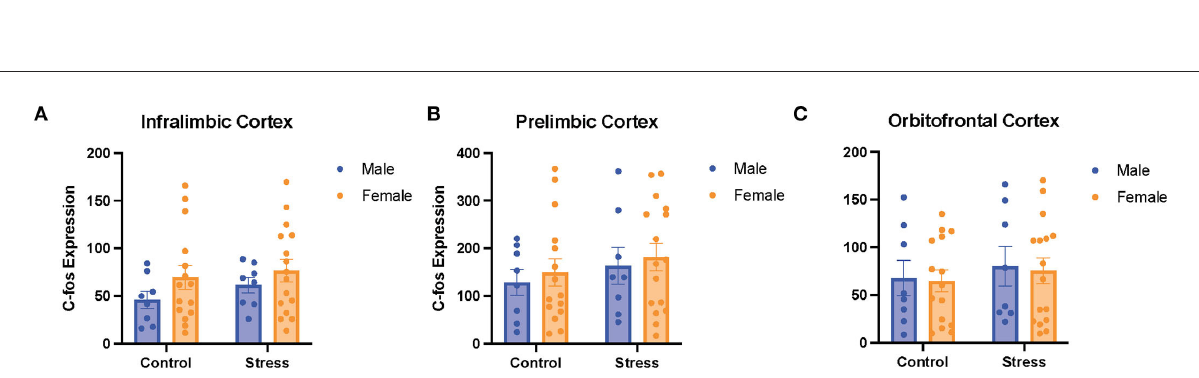
FIGURE8 There was no effect of stress or sex on c-fos expression in different subregions of the PFC. C-fos expression in the (A) infralimbic cortex, (B) prelimbic cortex, and (C) orbitofrontal cortex for the male and female rats in the control or stress conditions. Two-way ANOVAs followed by Tukey post-hoc tests were conducted to examine the relationship between stress, sex, and c-fos expression for the male ( n = 16: control = 8, and stress = 8) and female ( n = 32, control = 16, and stress = 16) rats. Error bars are plotted as mean ±